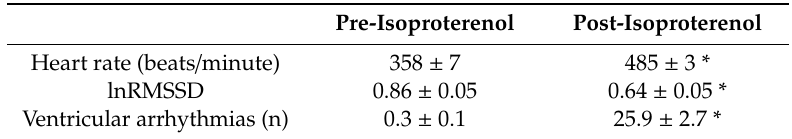
Table 3. Summary of the hierarchical regression analysis for variables predicting the total number of ventricular arrhythmias under β -adrenoreceptor pharmacological stimulation with isoproterenol.